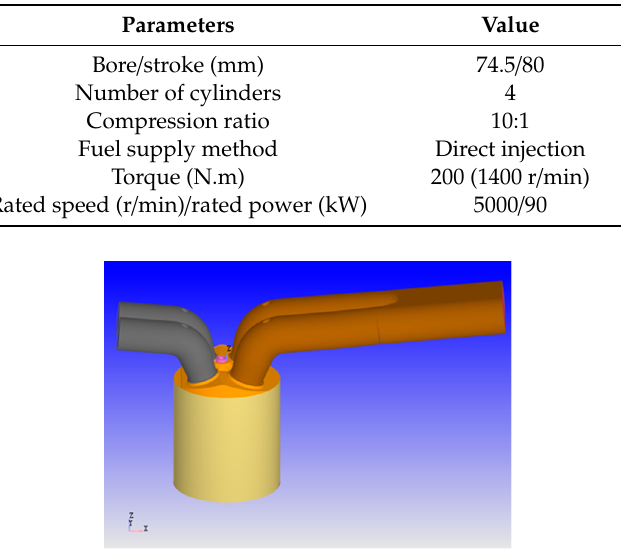
Figure 1. Geometry of the engine.